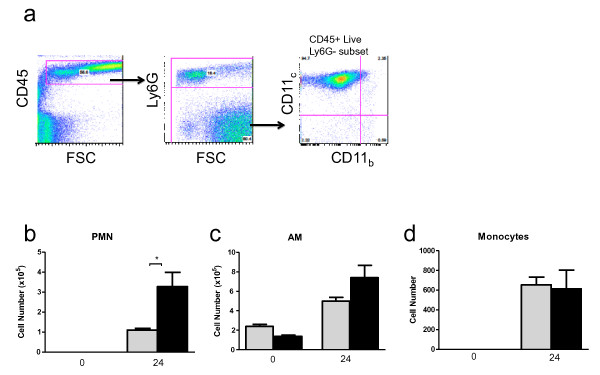
Increased pulmonary inflammation in SPC-sICAM-1 mice after K. pneumoniae infection is due to recruitment of both mononuclear cells and neutrophils. SPC-sICAM-1 mice and wild-type mice were intranasally inoculated with 250 CFU of K. pneumoniae. After 24 hours, the animals were euthanized, and whole lung lavage was performed. Cells were examined by flow cytometry with a gating strategy to identify leukocyte subpopulations as described in materials and methods (a, representative plot, SPC-ICAM-1 at 24 hours). SPC-sICAM-1 had greater accumulation of neutrophils (b), AM (c), and monocytes (d), compared to wild-type at 24 hours, although the differences in AM and monocyte numbers did not reach statistical significance. Data are expressed as mean ± SEM. (n = 6 in all groups; * P < 0.05 compared to wild-type).